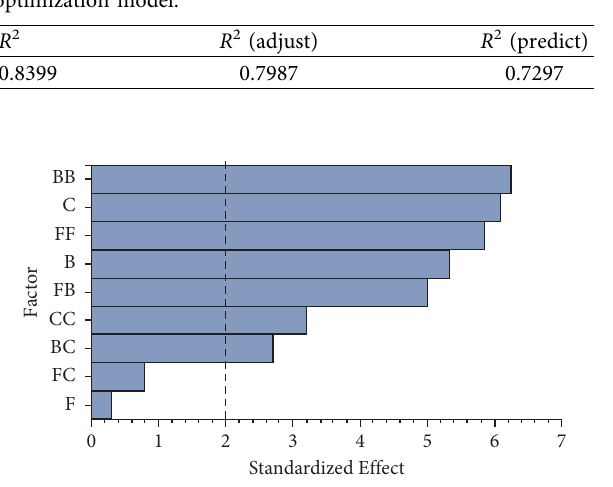
Figure 9: Pareto diagram for Box − Behnken optimization of cul- ture conditions with strain 290. Te dotted line represents the signifcance limit ( α � 0.05). PVC concentration (F), agitation rate (B), and pH (C). Combined letters represent the interaction be- tween culture conditions.